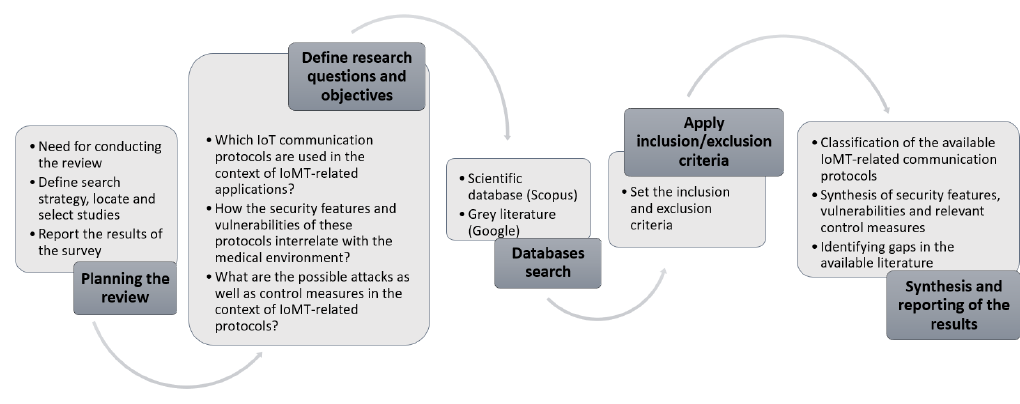
Figure 1. Steps of the overall research